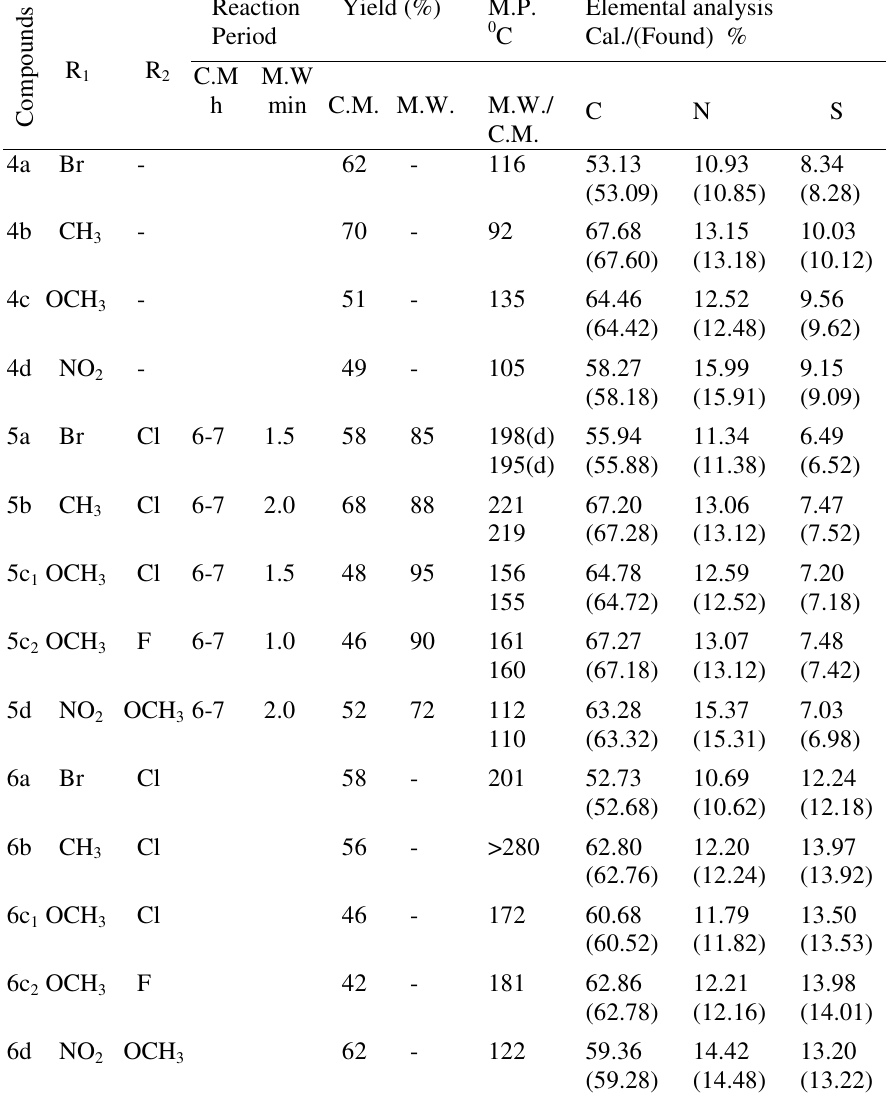
Table 1 . Physico-chemical data of synthesized compounds (C.M. = Conventional method, M.W. =